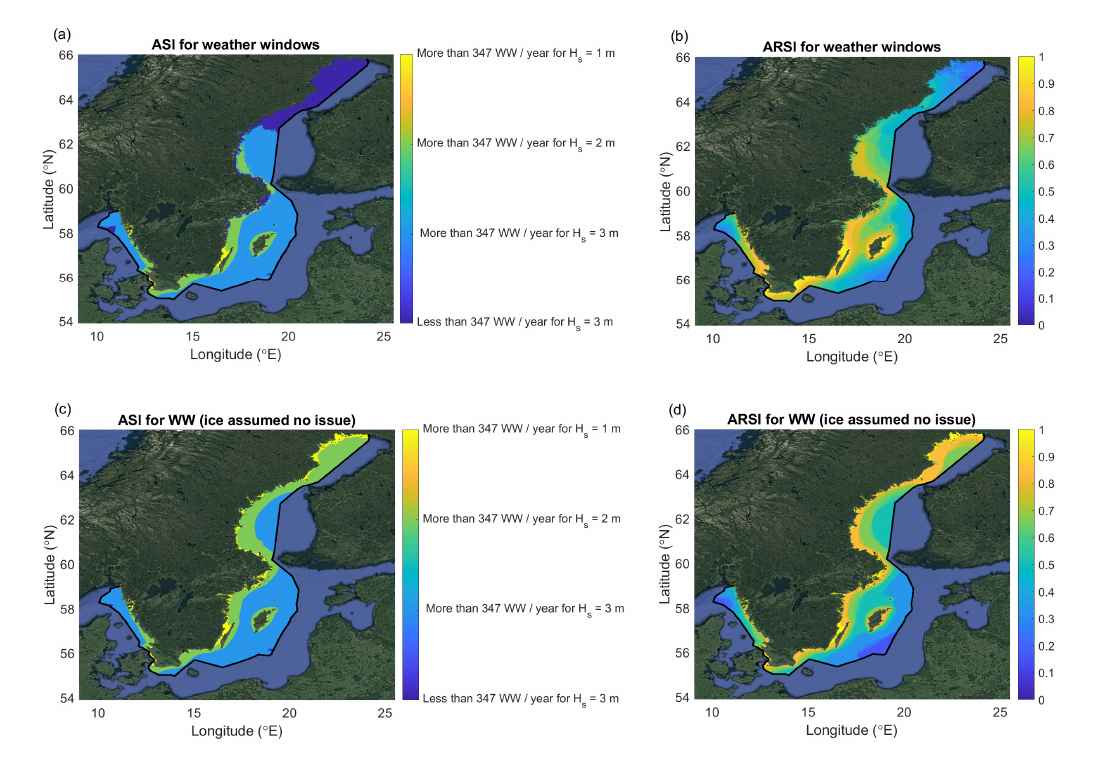
Figure 11. The ASI for weather windows based on considering if the number of weather windows was above or below 347 per year for each of the categories (in ( a , c )) and considering the percentile limits to formulate the ARSI in ( b , d ). The sub-plots ( a , b ) refer to considering the ice seen by the wave model as inhibiting for defining weather windows, and ( c , d ) are the corresponding figures assuming ice is not inhibiting O&M activities. A value of one indicates the best weather window conditions for all categories considered, and low values imply the presence of a reduced number of weather windows (WW) for many of the categories